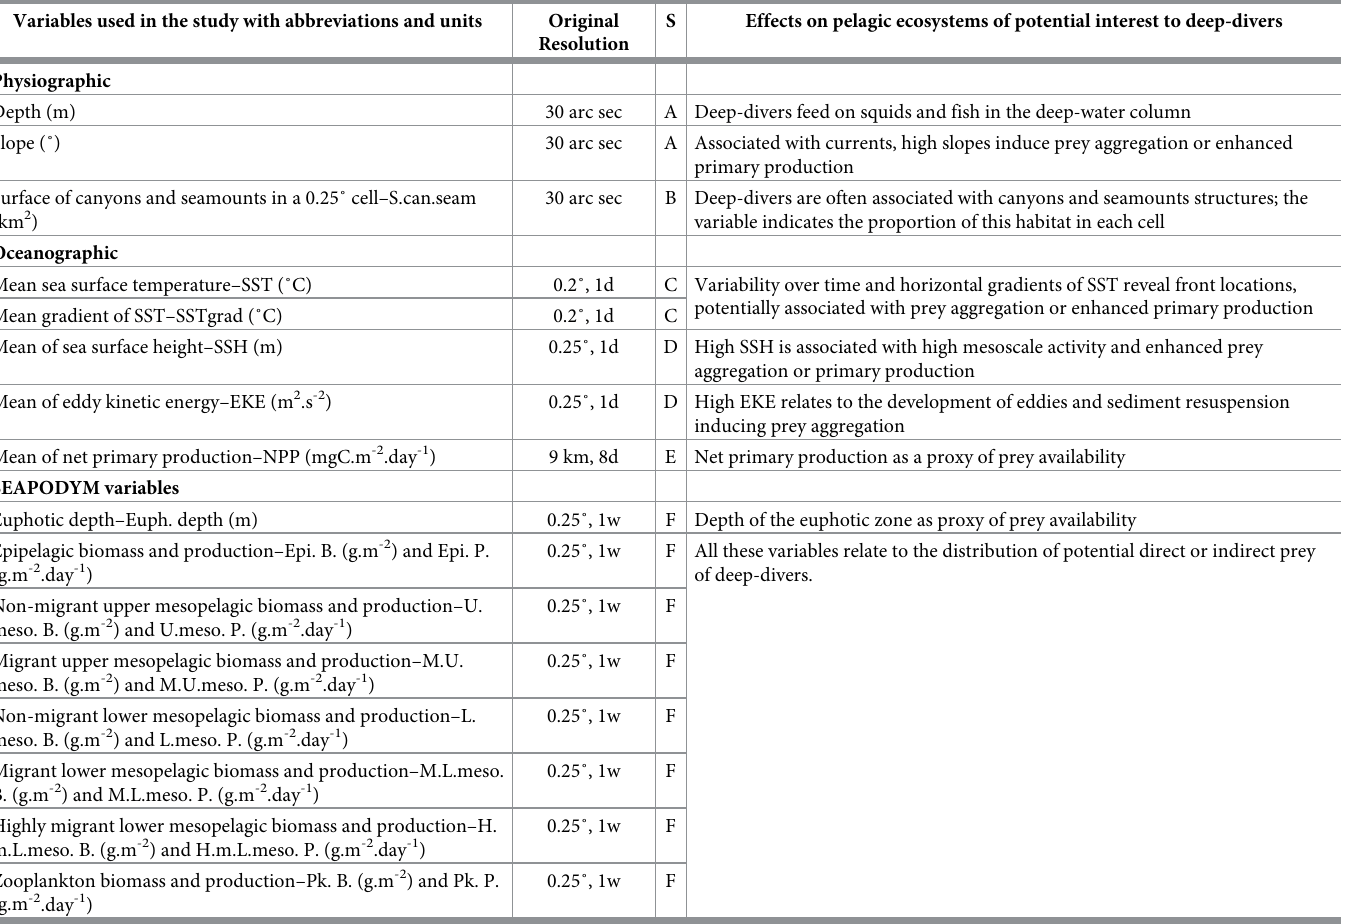
Table 2. Candidate environmental and SEAPODYM predictors used for the habitat-based density modelling. Variables used in the study with abbreviations and